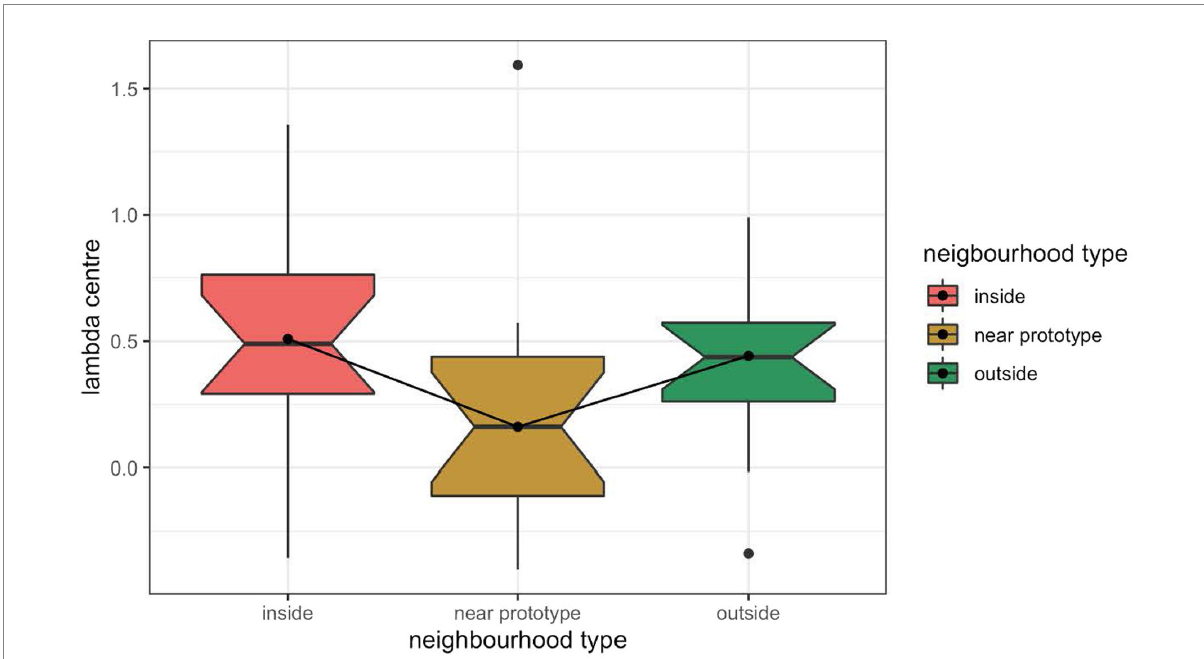
λ -Center for discrimination performance in the prototype referent condition (middle) and in the inside-limit non-prototype referent condition (left) and outside-limit non-prototype referent condition (right) in Experiment